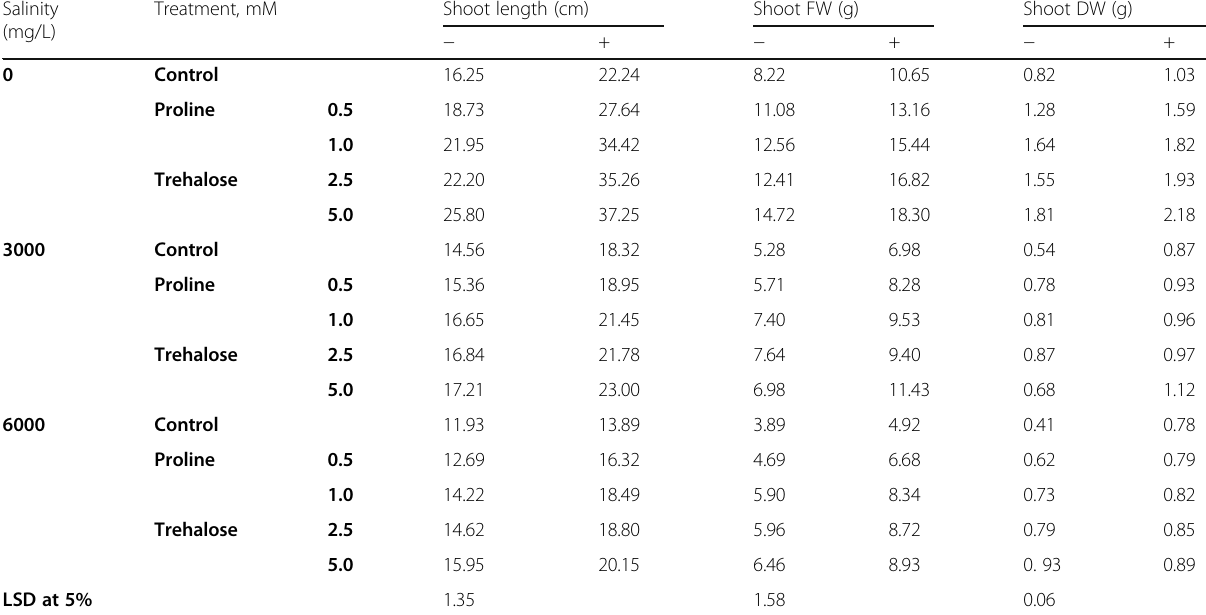
Table 3 Morphological criteria of quinoa plants treated with proline or trehalose with (+) and without ( − ) compost amendment under salinity stress (average of two seasons) Salinity Treatment, mM Shoot length (cm) Shoot FW (g) Shoot DW (g) (mg/L) − + − 0